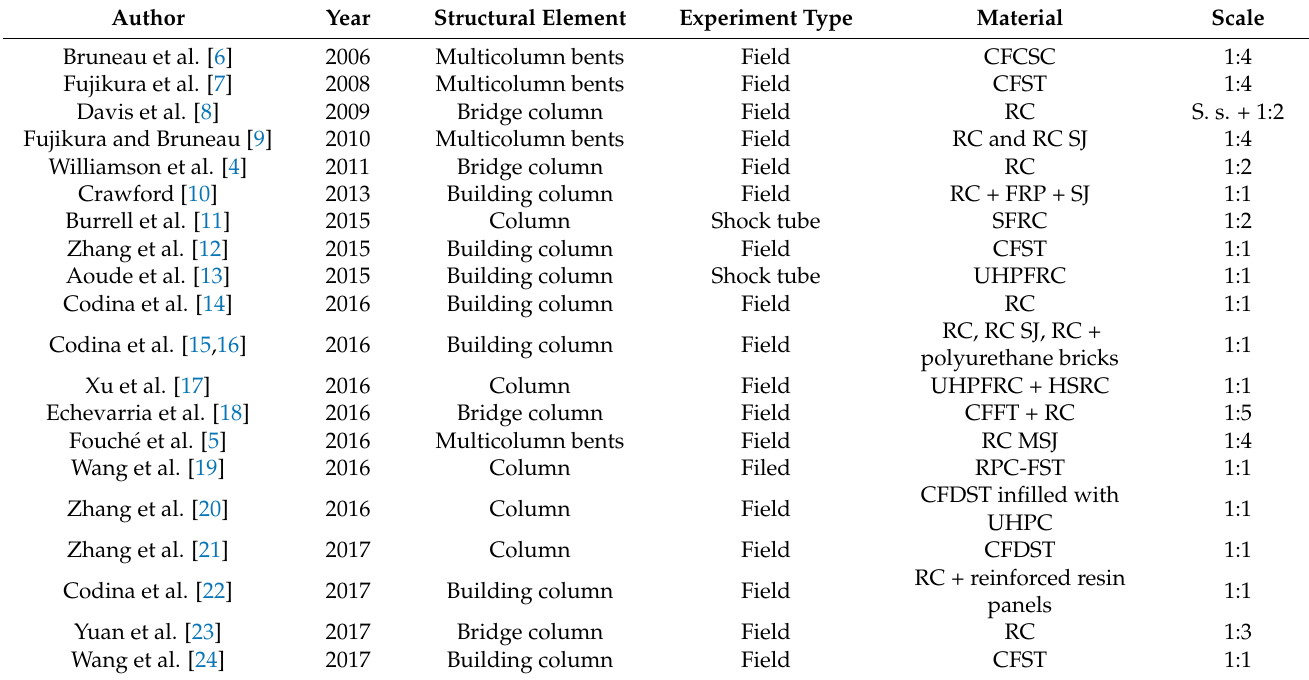
Table 1. Summary of experimental